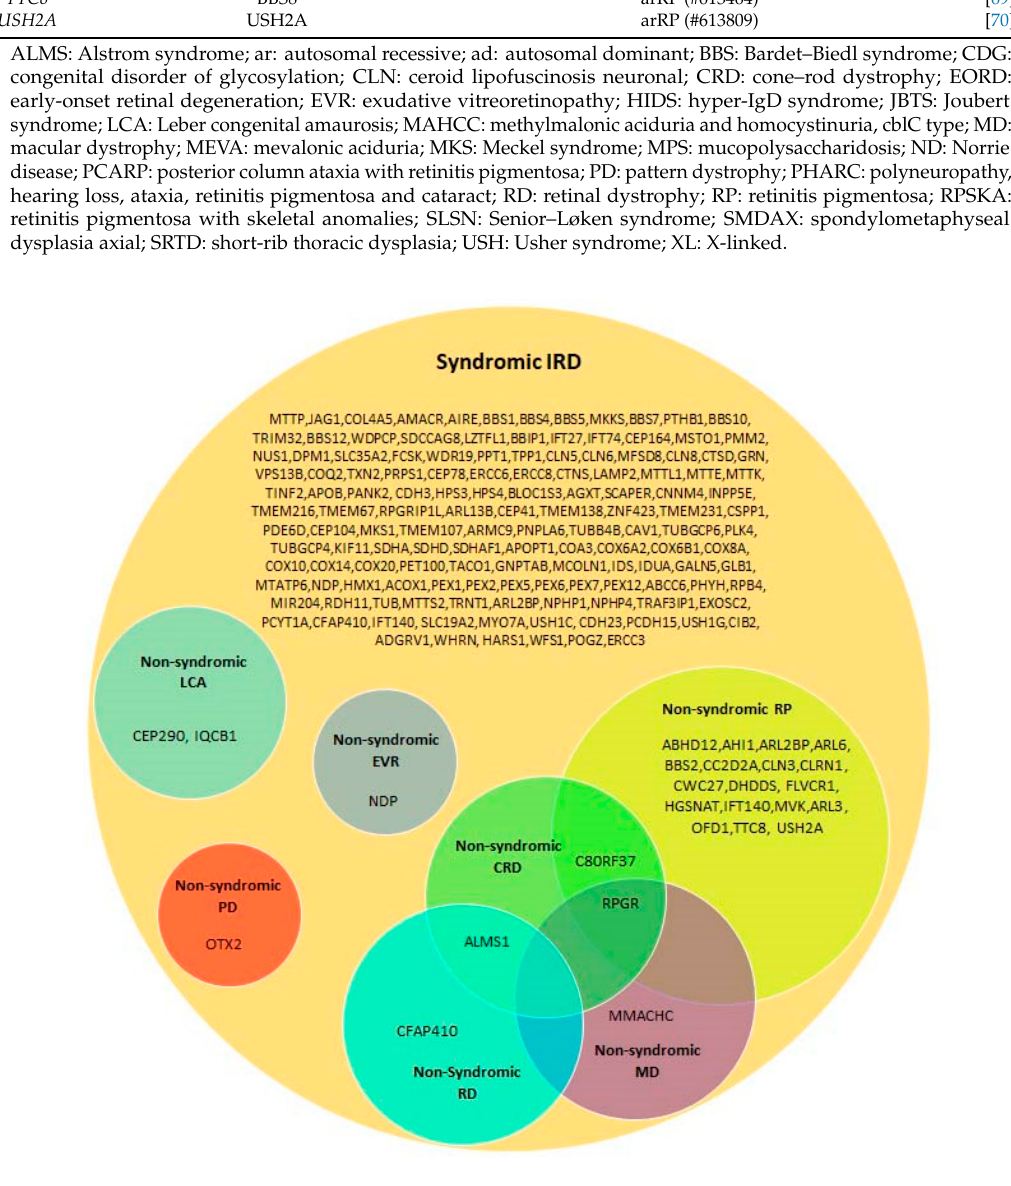
Figure 2. A Venn diagram showing the involvement of syndromic IRD genes in non-syndromic IRD